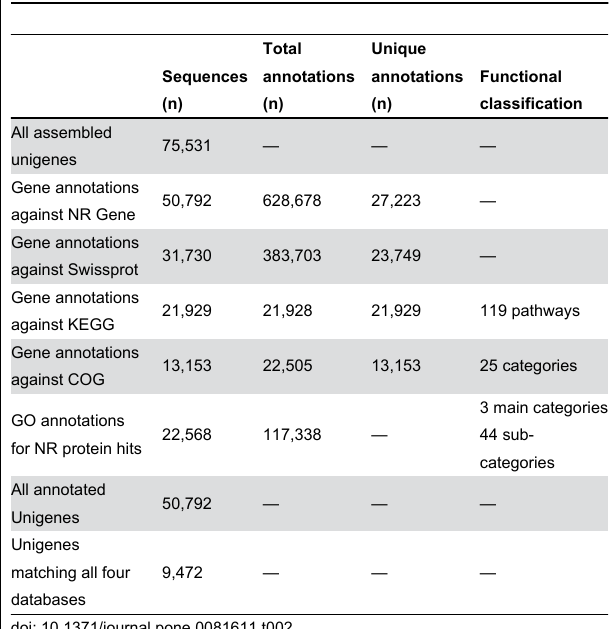
Table 2. Summary of annotations for the C. sinensis floral transcriptome.